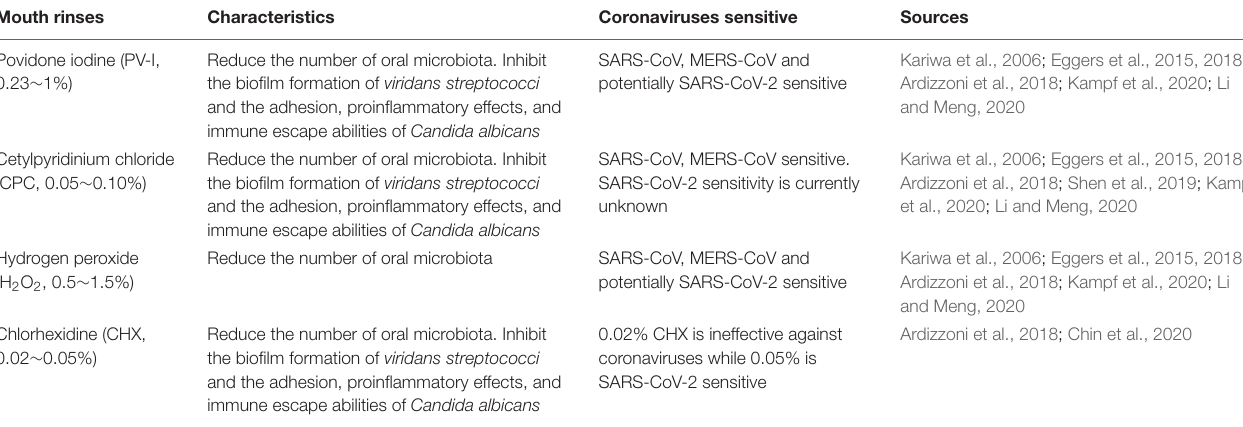
TABLE 1 | Characteristics of four common components of mouth